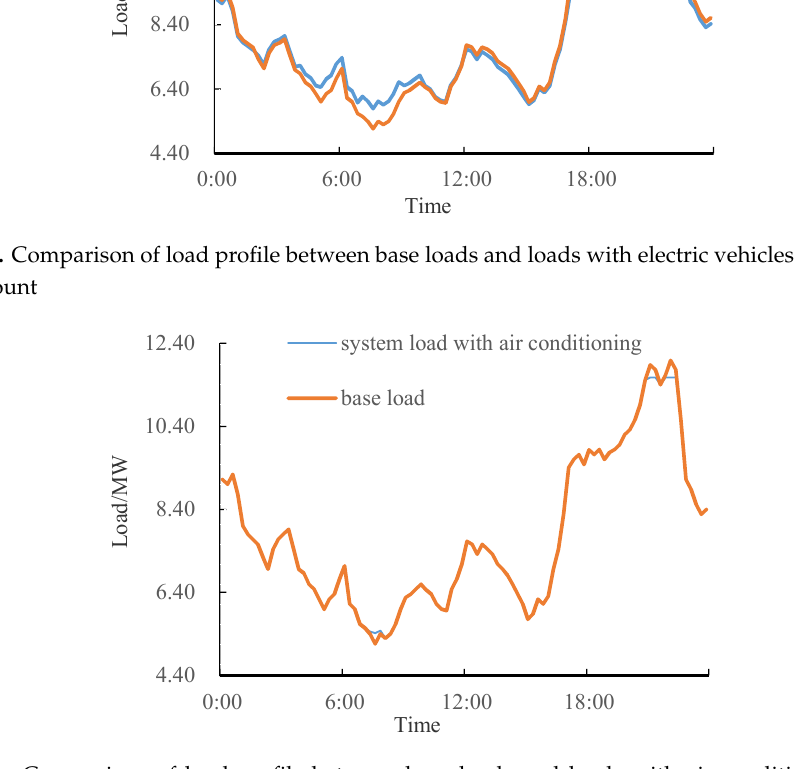
Figure 8. Comparison of load profile between base loads and loads with air conditioning taken into account.